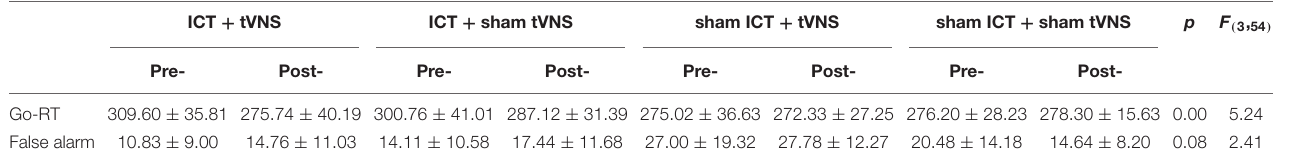
TABLE 2 | The mean of Go/No-go in pre- and post-training tests (M ± SD). ICT + tVNS ICT + sham tVNS sham ICT + tVNS sham ICT + sham tVNS p F ( 3 , 54 ) Pre-